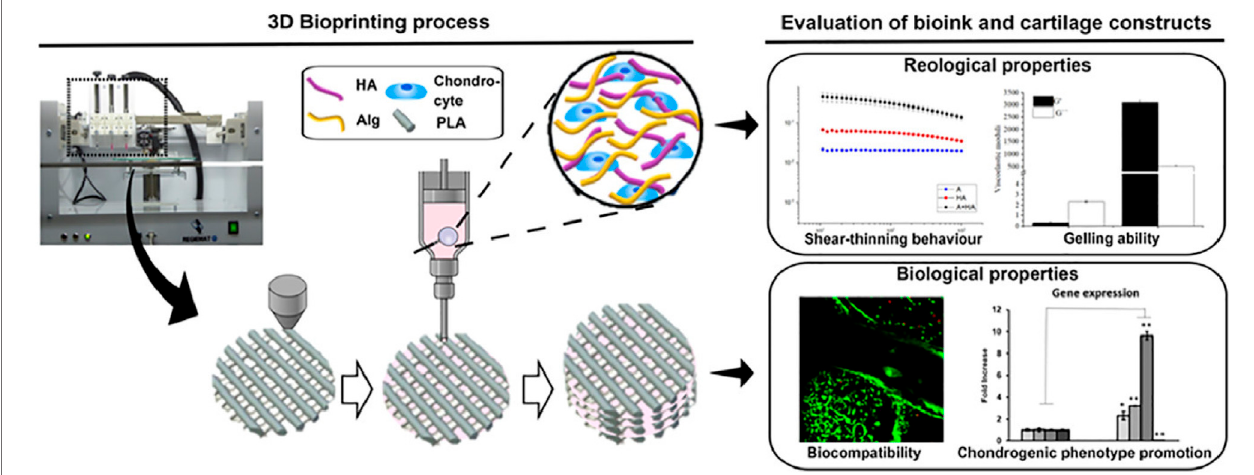
FIGURE9| SchematicpreparationofPLA-basedbioprintingscaffoldsofarticularcartilageengineering.ReproducedfromAntichetal.,(2020)withpermissionfrom Copyright 2016 Elsevier.